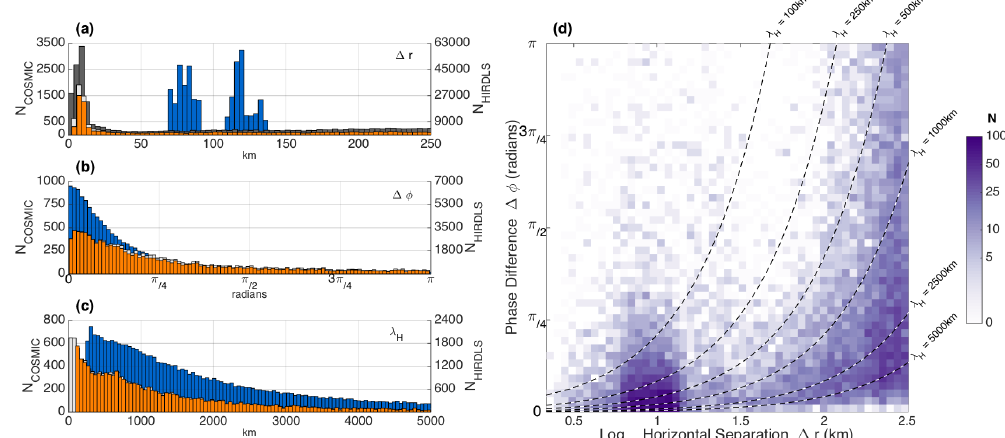
Figure A2. Number of COSMIC ( N COSMIC , orange and grey bars) and HIRDLS ( N HIRDLS , blue bars) profile pairs against (a) horizontal separation (cid:49)r , (b) phase difference (cid:49)φ and (c) projected horizontal wavelength λ H globally for June–August 2006. Dark grey bars in (a) correspond to all available COSMIC profile pairs. Light grey bars in (a–c) correspond to COSMIC profile pairs in which a coherent wave was identified via the Wave-ID method. Orange bars in (a–c) correspond to COSMIC profile pairs in which a wave was identified with 100 < λ H < 5000km. Panel (d) shows a density plot of number of COSMIC profile pairs N against horizontal separation and phase difference. Dashed black lines of constant λ H are found via the relation in Eq.